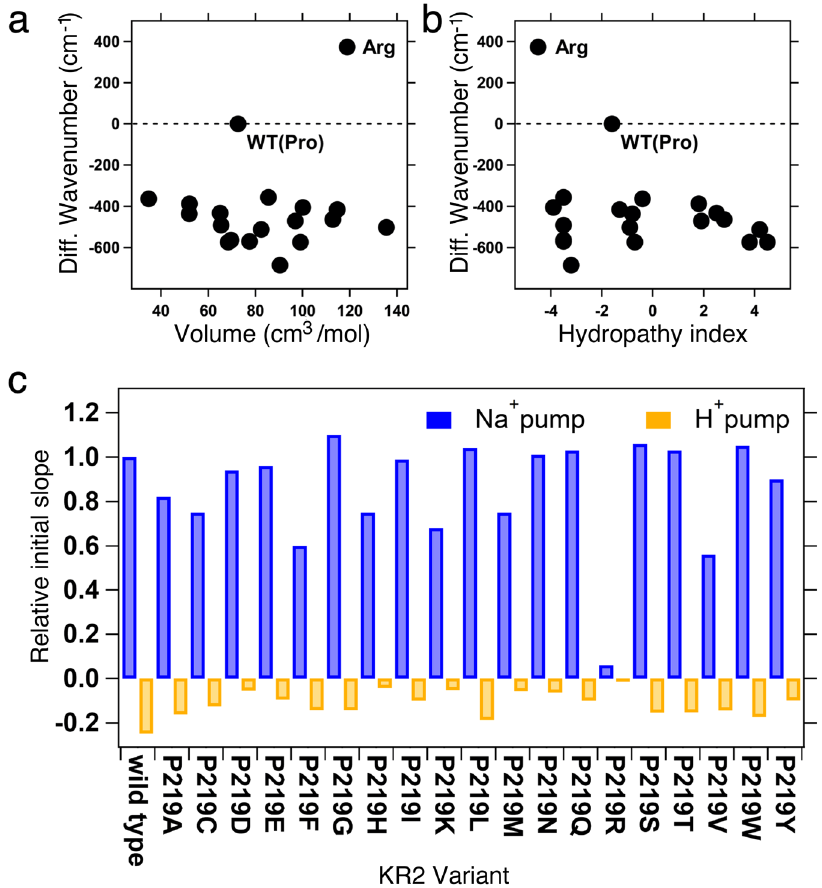
Fig. 3 Experimental Data. Correlation between the absorption light energy and ( a ) the volume or ( b ) hydropathy index of the amino acid residue at position 219 in KR2. The y-axis represents the difference in wavenumber from that of the wild type (reciprocal λ max ; cm − 1 ), where positive and negative values correspond to the spectral blue- and red-shifts, respectively. ( c ) Quantitative comparison of pump activities of the WT-KR2 and mutant KR2. The numbers of protons taken in or released from the cells by the pump activity of KR2 and each mutant per one protein molecule in one second are shown. The values were estimated from the initial slope of light induced pH changes and the expression levels of the proteins. E. coli cells suspensions expressing KR2 mutants are illuminated at >520 nm light, and quanti fi ed proton release and uptake are measured in the solution containing 100 mM NaCl (blue bars) and CsCl (orange bars). Positive values indicate the numbers of protons which are taken into cells by one protein molecule per second, which originates from outward Na + pump. Negative values indicate the numbers of protons which are released from cells by one protein molecule per second, which originates from outward proton